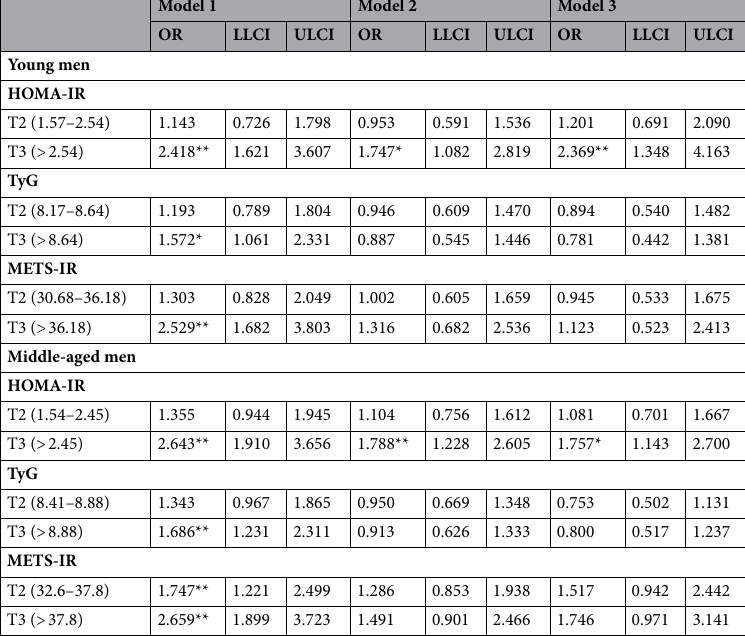
Table 2. Logistic regression analysis for the association of three IR indicators with ISH. Model 1 was crude. Model 2 was adjusted for abdominal obesity and non-alcoholic fatty liver. Model 3 was adjusted for abdominal obesity, non-alcoholic fatty liver, hyperuricemia, smoking, and drinking. OR Odds ratio, LLCI and ULCI lower level and upper level of 95% confidence interval, T tertile; the first tertile was used as the reference